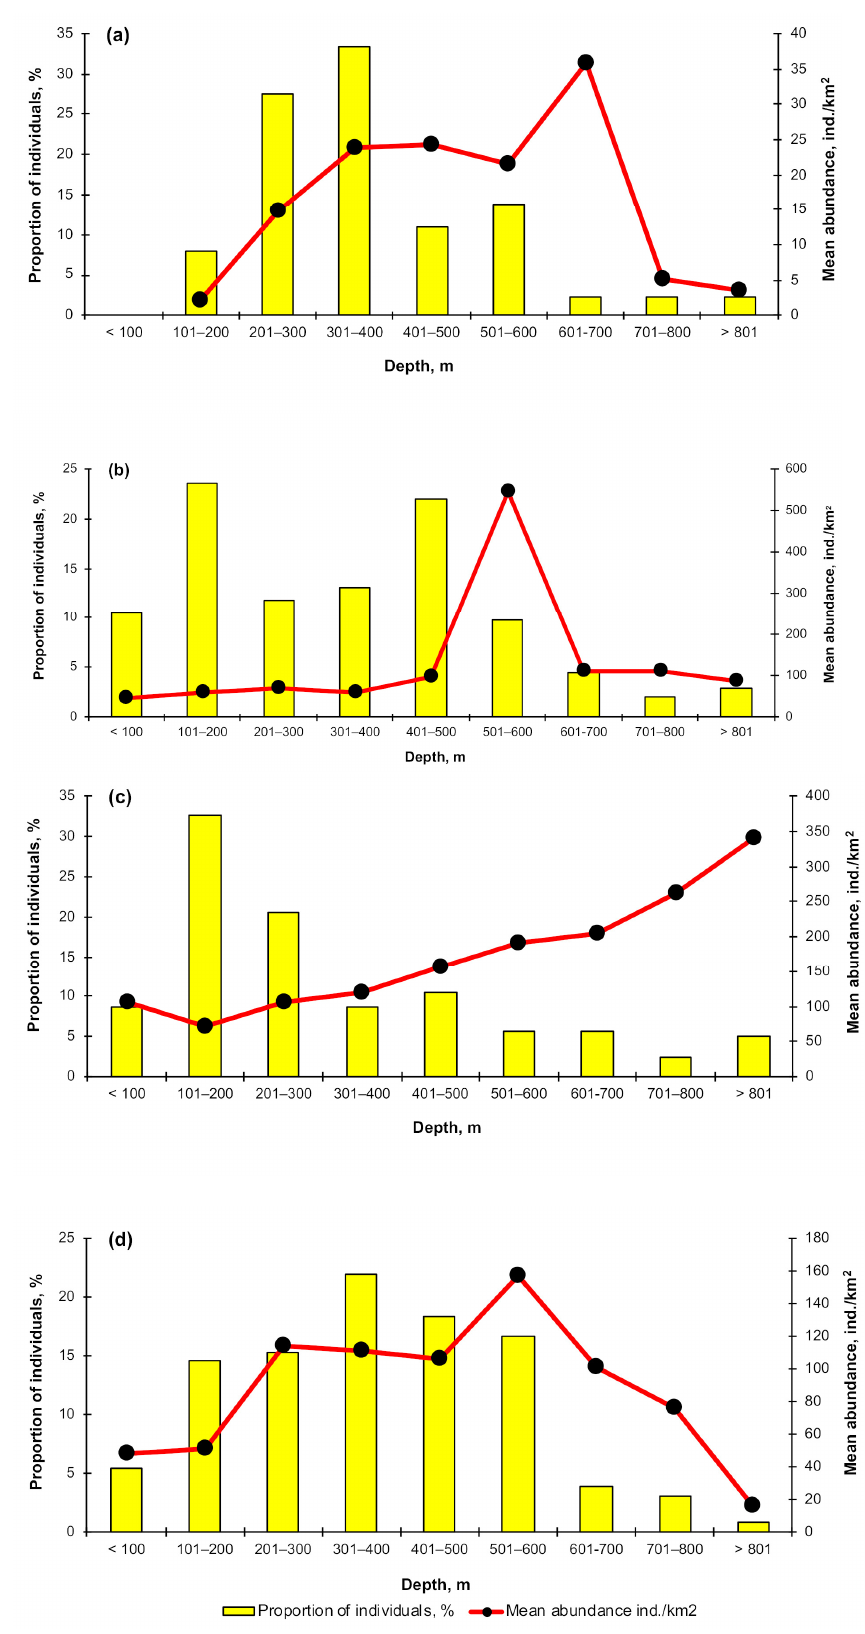
Figure 8. Depth distribution of the Aleutian skate Bathyraja aleutica across the North Pacific by